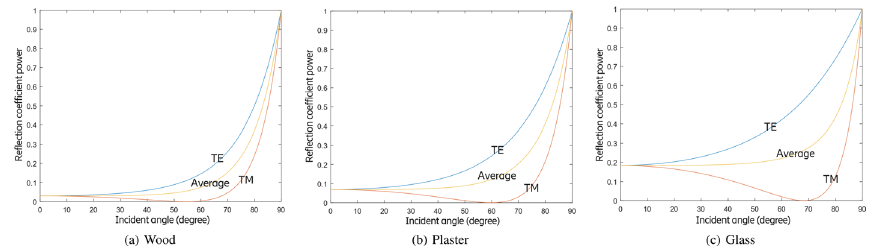
Fig. 7 Reflection coefficient power for air/wood, air/plaster, and air/glass interfaces at 100